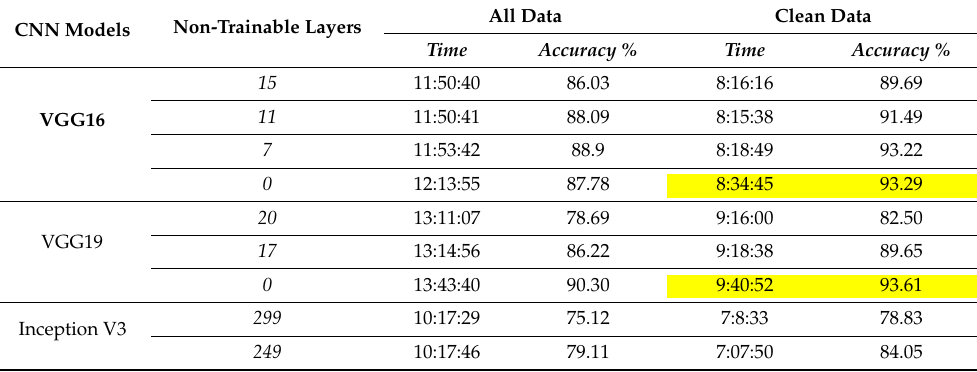
Table 2. Comparison of accuracies of fine-tuning different CNN models using all data and clean data (the yellow shaded ones are the best for the real-time